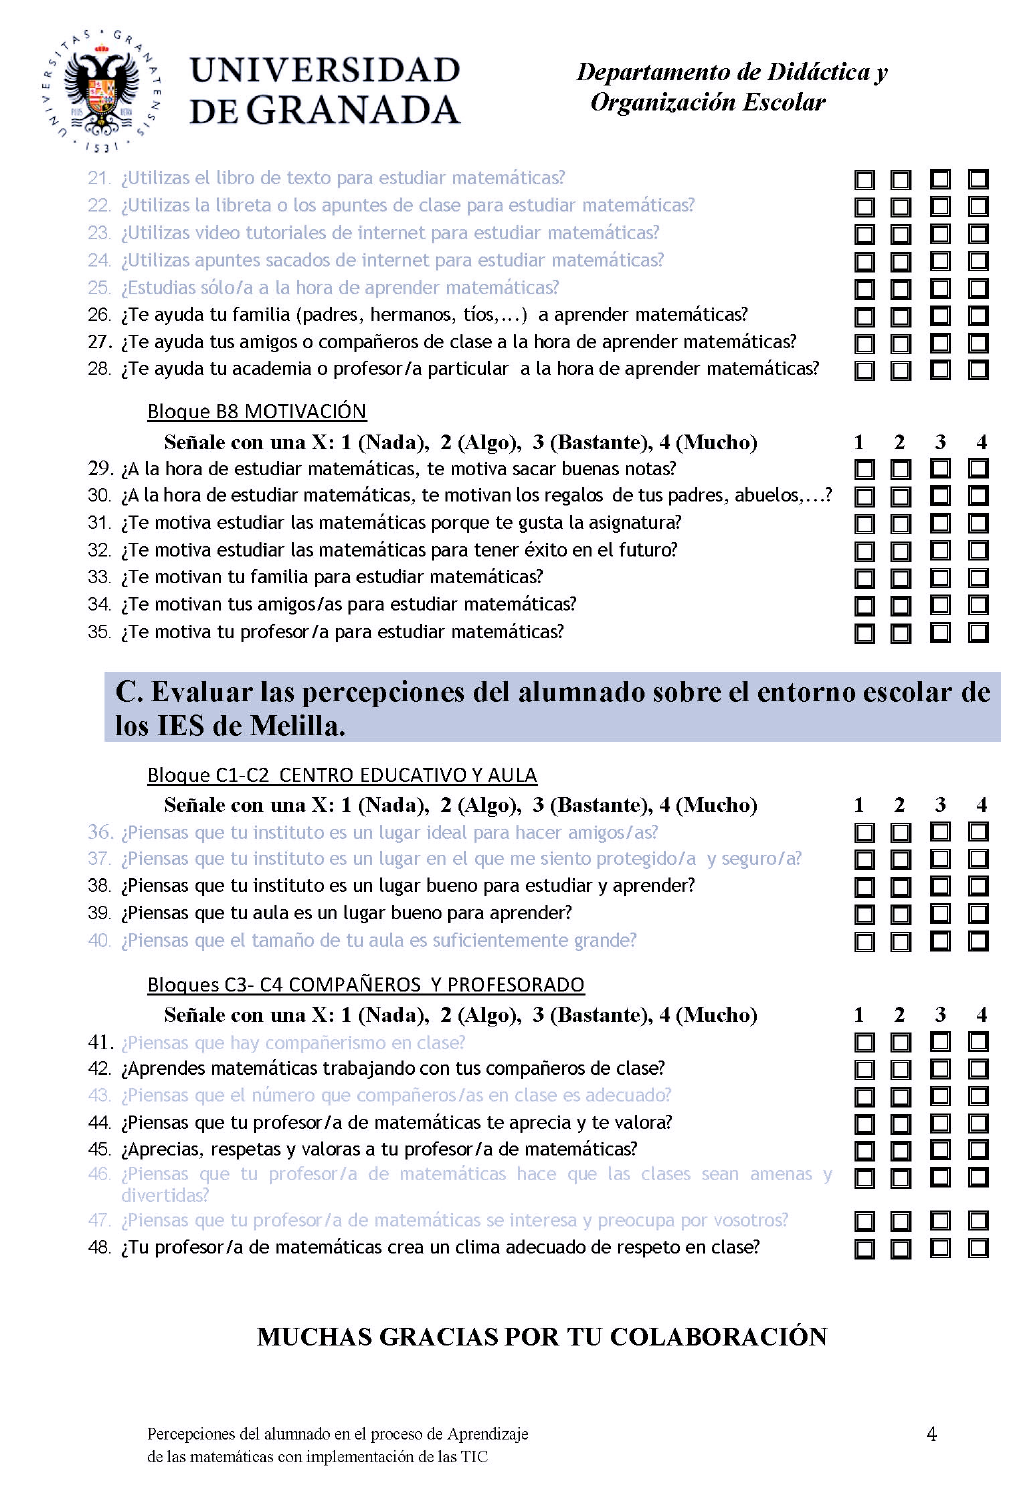
Figure A4. Items of dimension C “School Environment”.